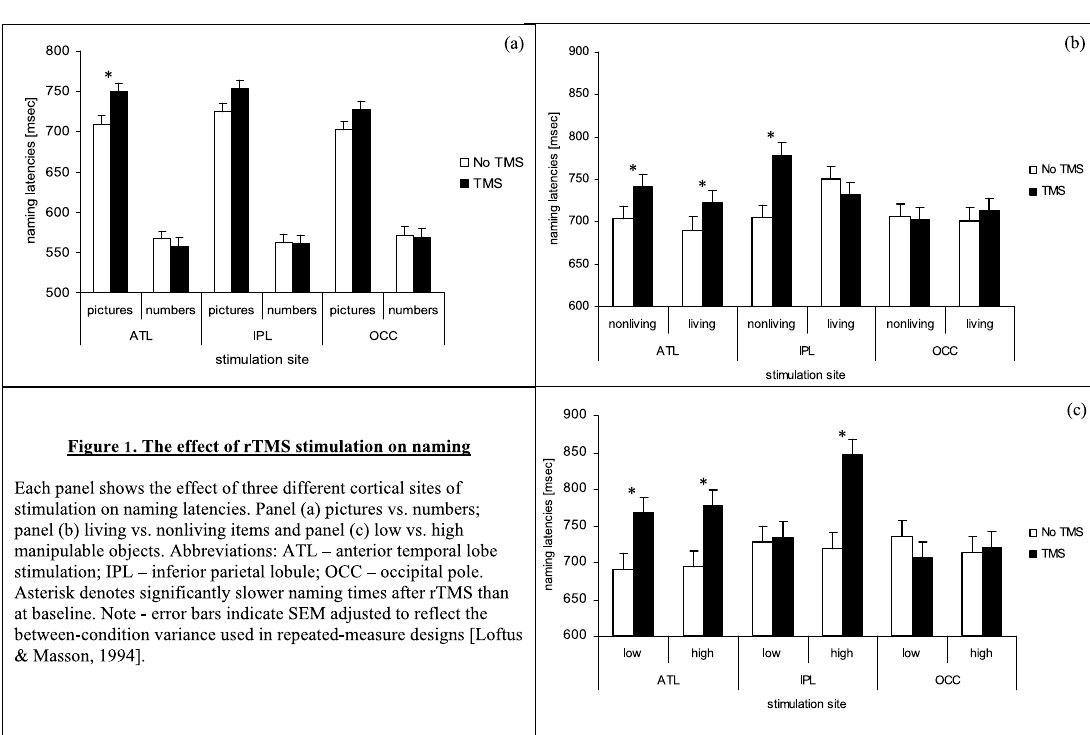
Fig. 1. The effect of rTMS stimulation on